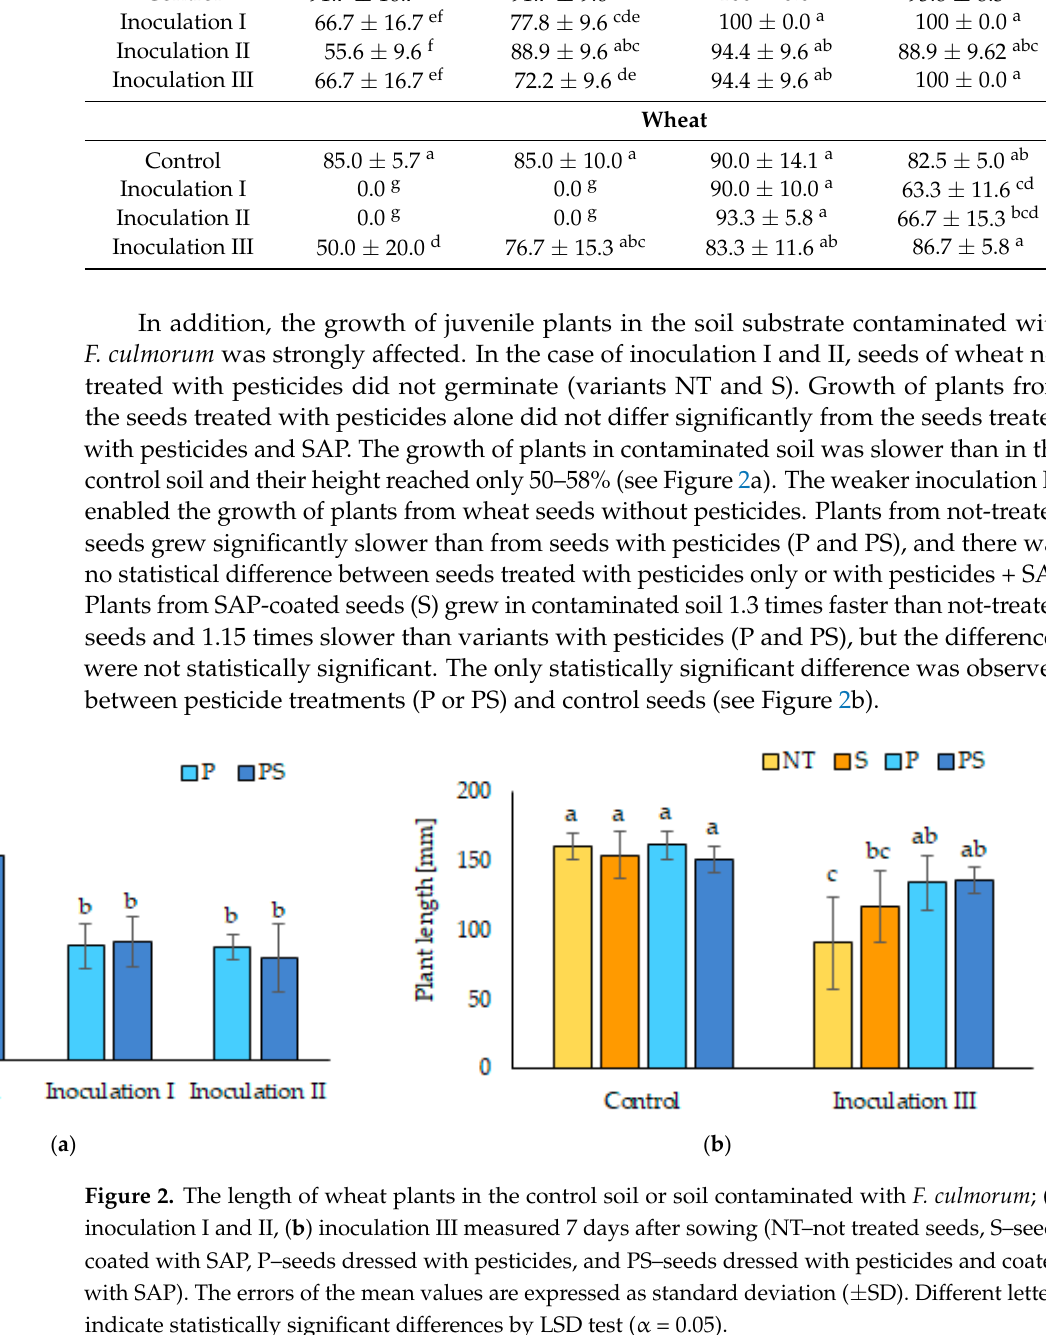
Table 1. Germination percentage of non-treated (NT) maize and wheat seeds and seeds treated with SAP (S), pesticide dressing (P), or pesticide with SAP (PS) in the control soil or soil contaminated with the inoculum of F. culmorum . The errors of the mean values are expressed as standard deviation ( ± SD). Different letters indicate statistically significant differences by LSD test ( α = 0.05). Seed Treatment NT S P PS Inoculation Maize Control